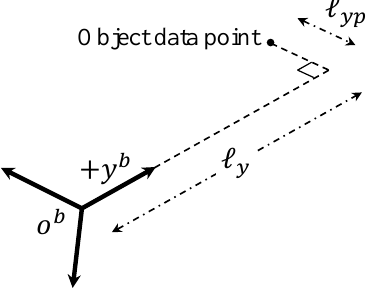
Figure 3. Object data point in the direction of + y b